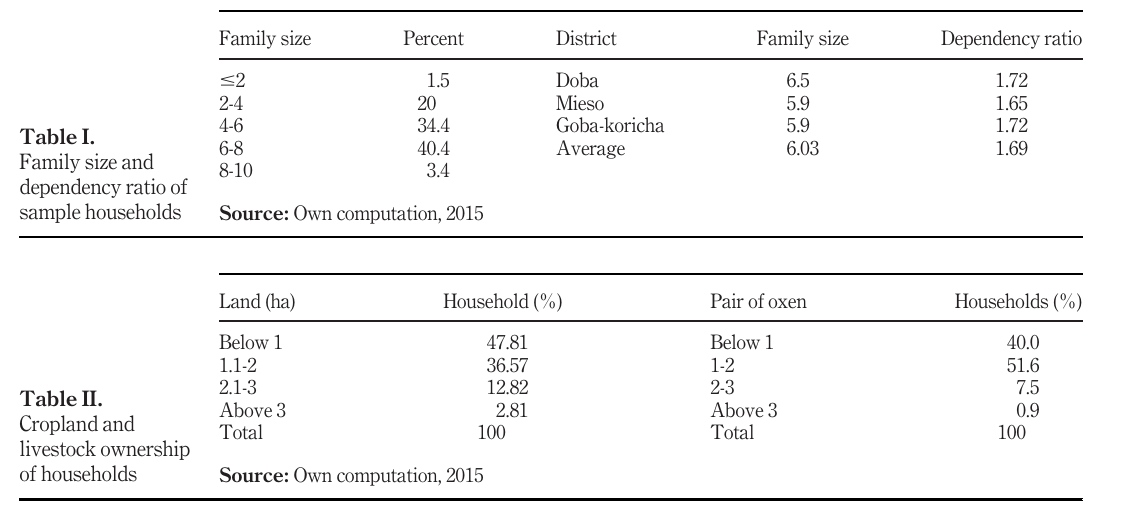
Table II. Cropland and livestock ownership of